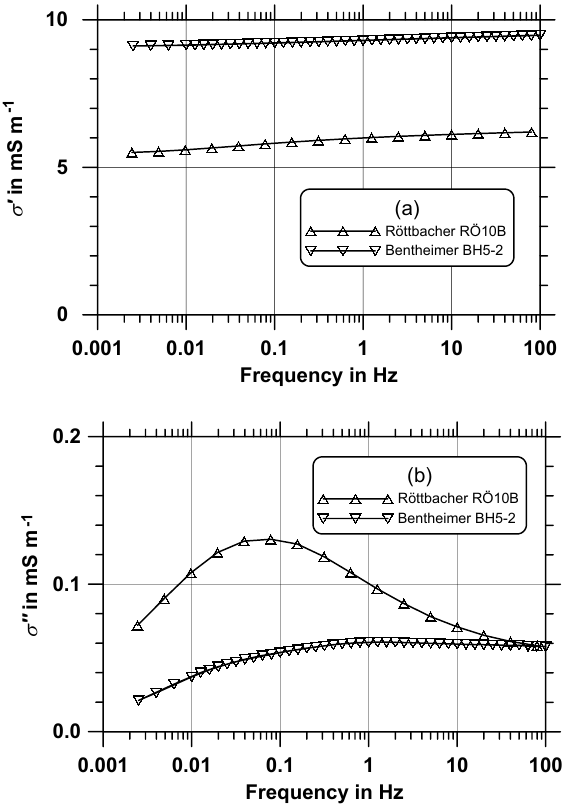
Figure 7. Measured complex conductivity spectra of samples BH5- 2 and RÖ10B; (a) real part of conductivity; (b) imaginary part of conductivity.